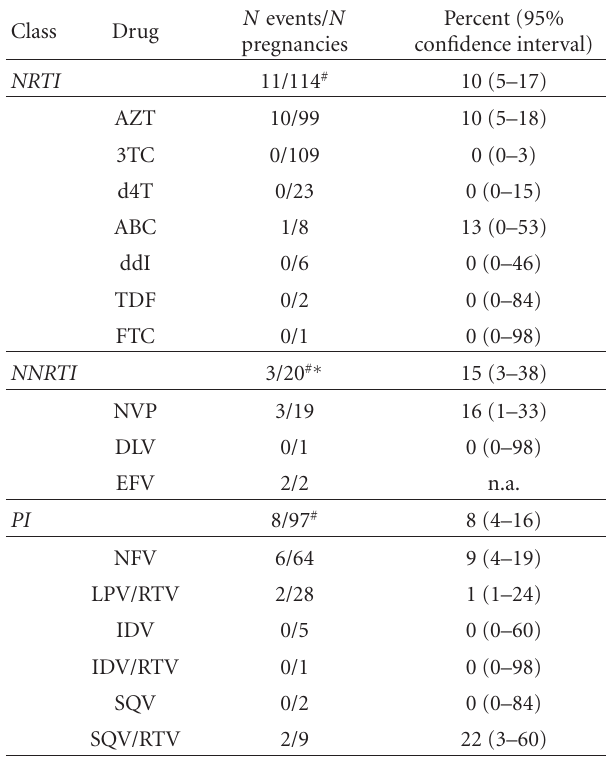
Table 3: Drug substitutions or discontinuations during